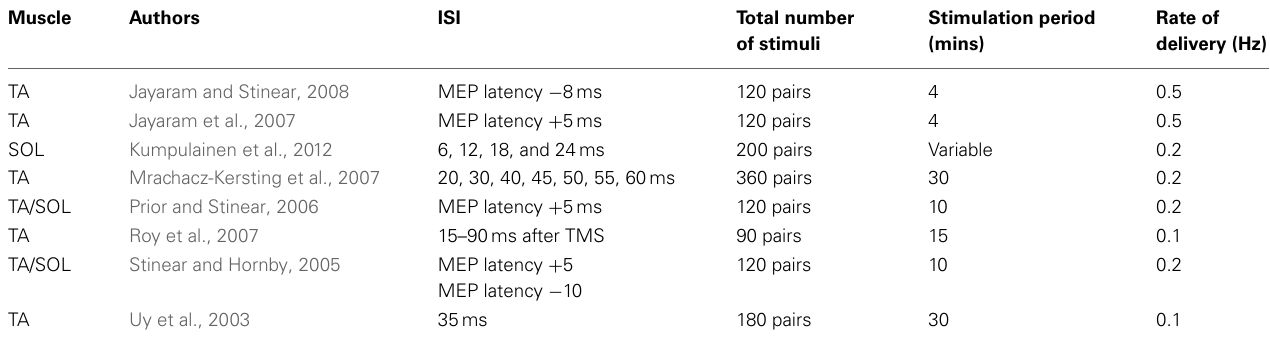
Table 3 | Lower limb